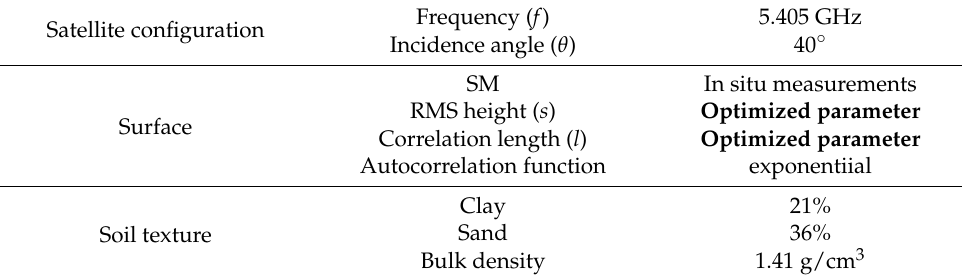
Table 2. Parameters needed for the